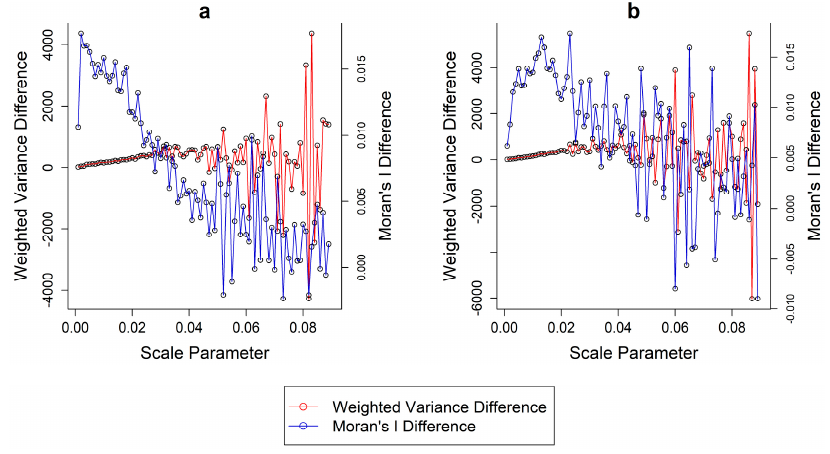
Figure 5. Differences in MI and WV between each computed segmentation and the next for ( a ) ROI 1 and ( b ) ROI 2. and ( b ) ROI